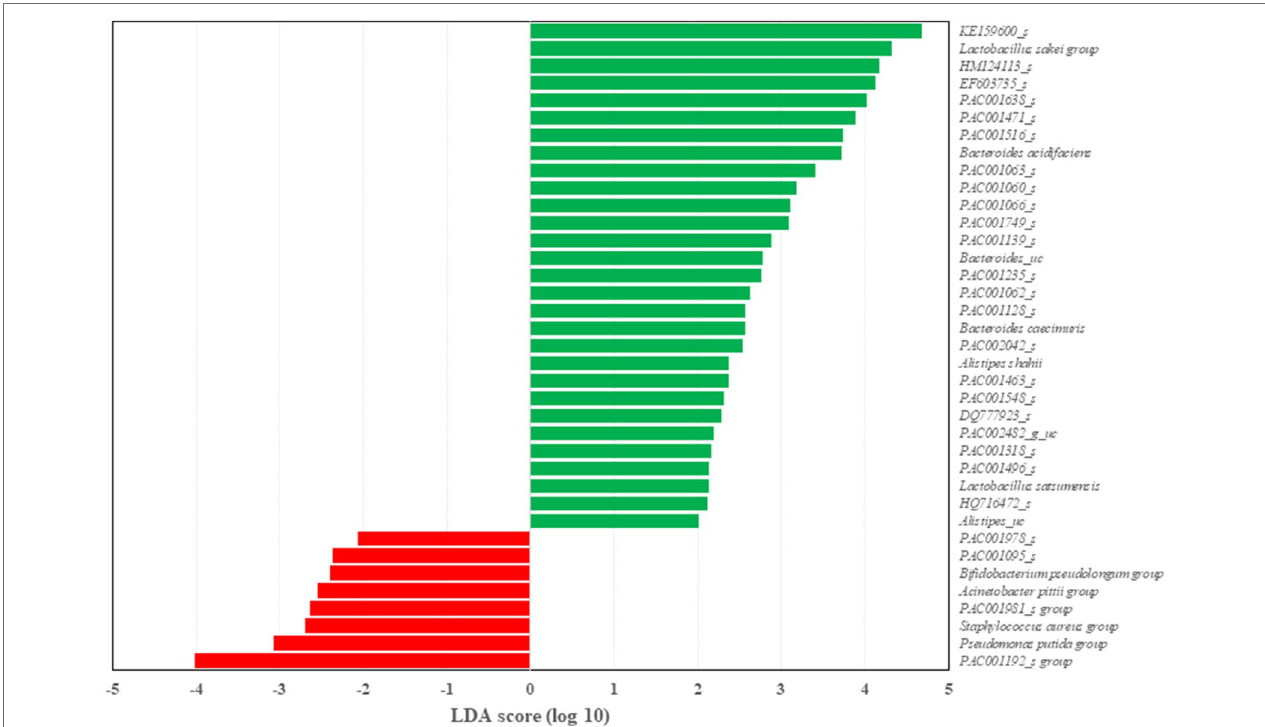
FIGURE 5 | Differentially represented genus between HD and HDA group through linear discriminant analysis effect size (LEfSe) analysis. Latent Dirichlet allocation (LDA) score indicates the effect size. n = 4–6 per